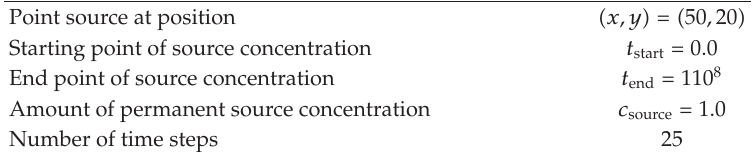
Table 6: Parameters of source concentration.